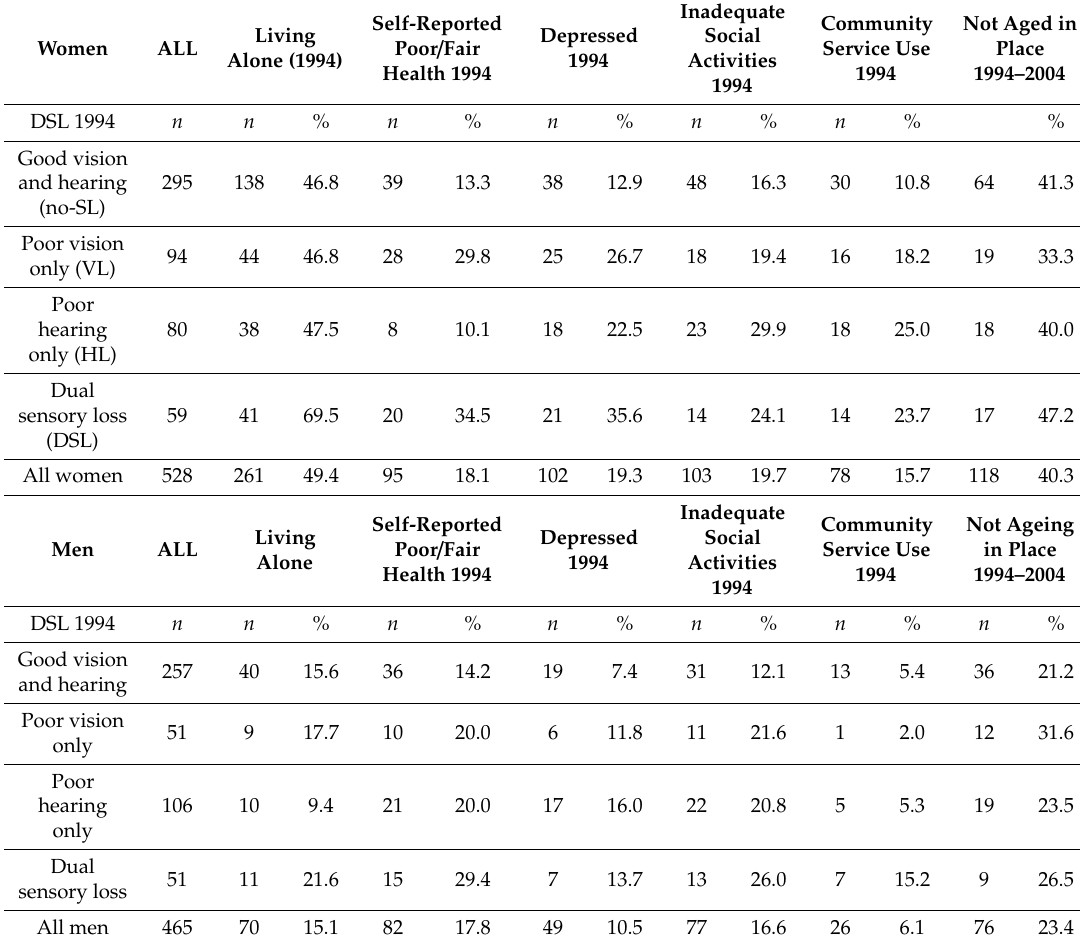
Table 7. DSL and associated social and health outcomes in 1994.